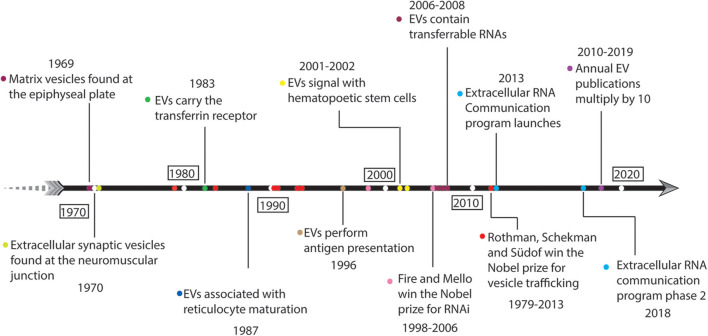
Fifty years of historical landmarks in extracellular vesicle-related research.